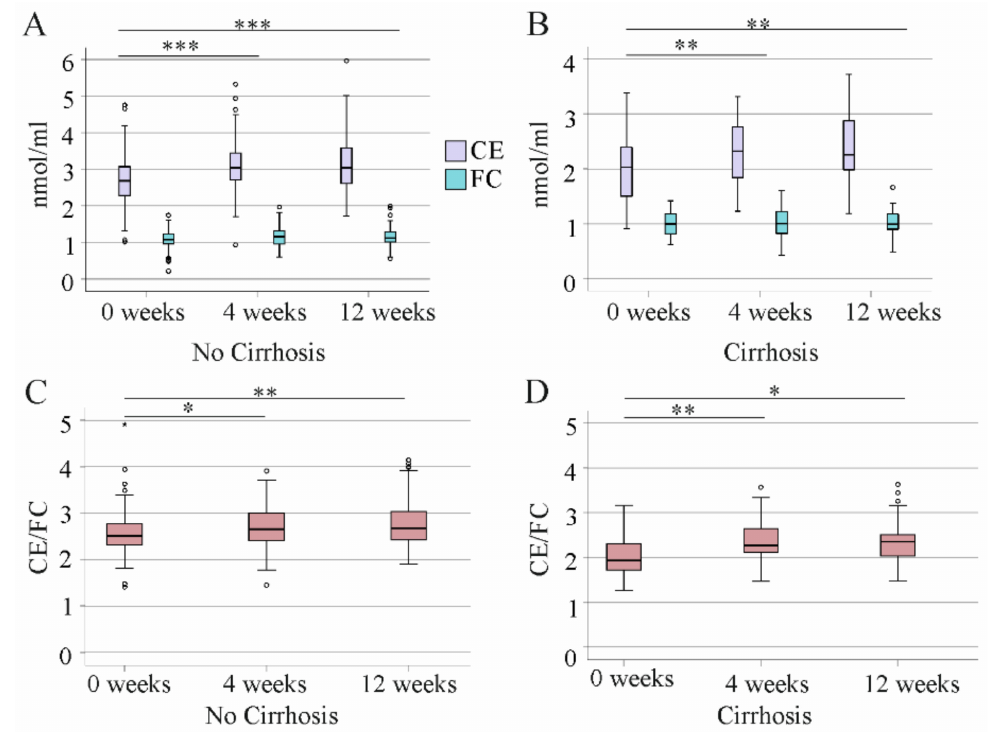
Figure 5. Cholesteryl ester (CE) and free cholesterol (FC) levels during the study. ( A ) Concentrations in serum of patients without cirrhosis diagnosed by ultrasound. ( B ) Concentrations in serum of patients with cirrhosis diagnosed by ultrasound. ( C ) CE/FC ratio in serum of patients without cirrhosis diagnosed by ultrasound. ( D ) CE/FC ratio in serum of patients with cirrhosis diagnosed by ultrasound. * p < 0.05, ** p < 0.01, *** p < 0.001. Small circles or asterisks above or below the boxes mark